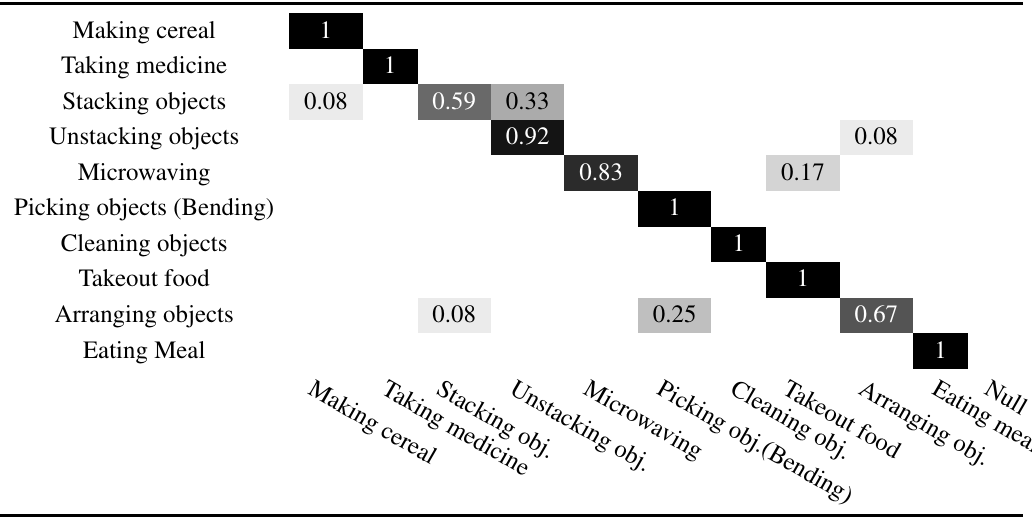
Table 13. Confusion matrix for high-level activities taking as input the sub-activities 100% perfectly labeled from the CAD-120 dataset (ideal